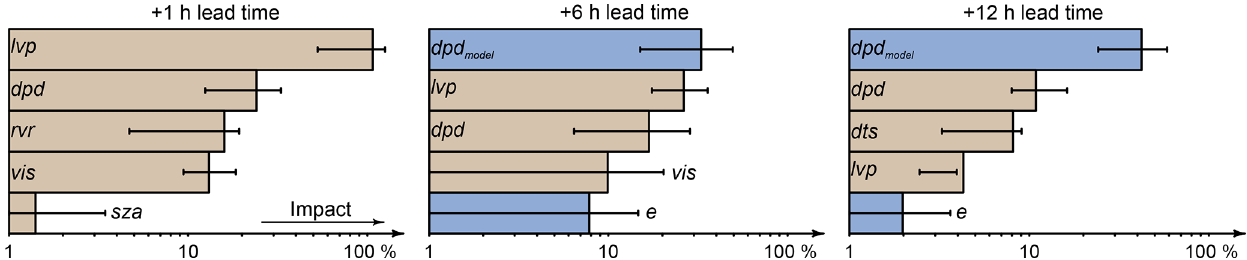
Figure 2. Predictors of Table 2 with the highest impact on boosting trees with the combined predictor setup for lead times of + 1, + 6, and + 12h. The tan color indicates observation-based predictors, and the blue color indicates HRES-based ones. The x axis is logarithmic and shows the mean percentage decrease in forecast performance when the true values of the particular predictor are replaced with random information. The error bars show the 25th to 75th percentiles of the performance decrease for the particular